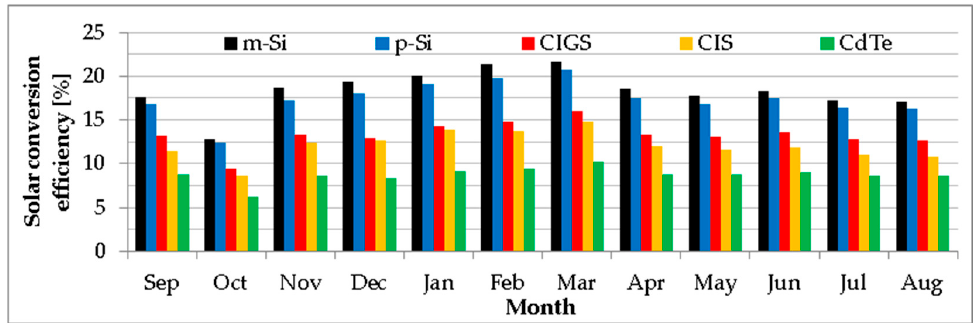
Figure 22. The monthly solar conversion efficiencies of the fixed photovoltaic modules.